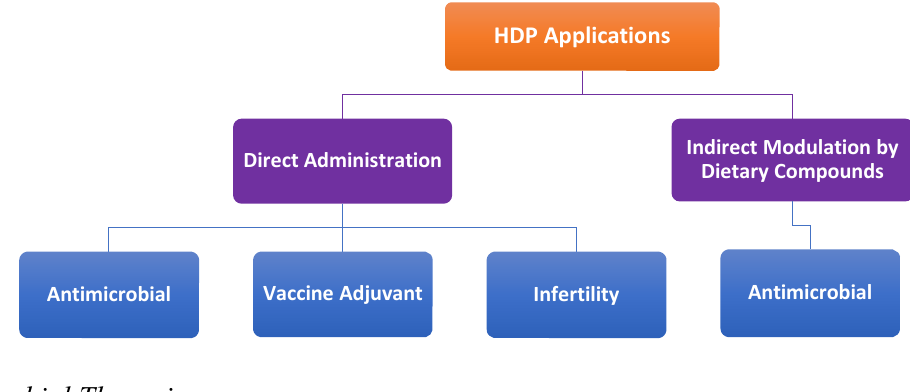
Figure 7. Potential therapeutic applications of host defense peptides (HDPs). Synthetic HDPs can be directly administered exogenously as antimicrobials, vaccine adjuvants or infertility drugs. Alternatively, endogenous HDPs can modulated by dietary compounds for antimicrobial